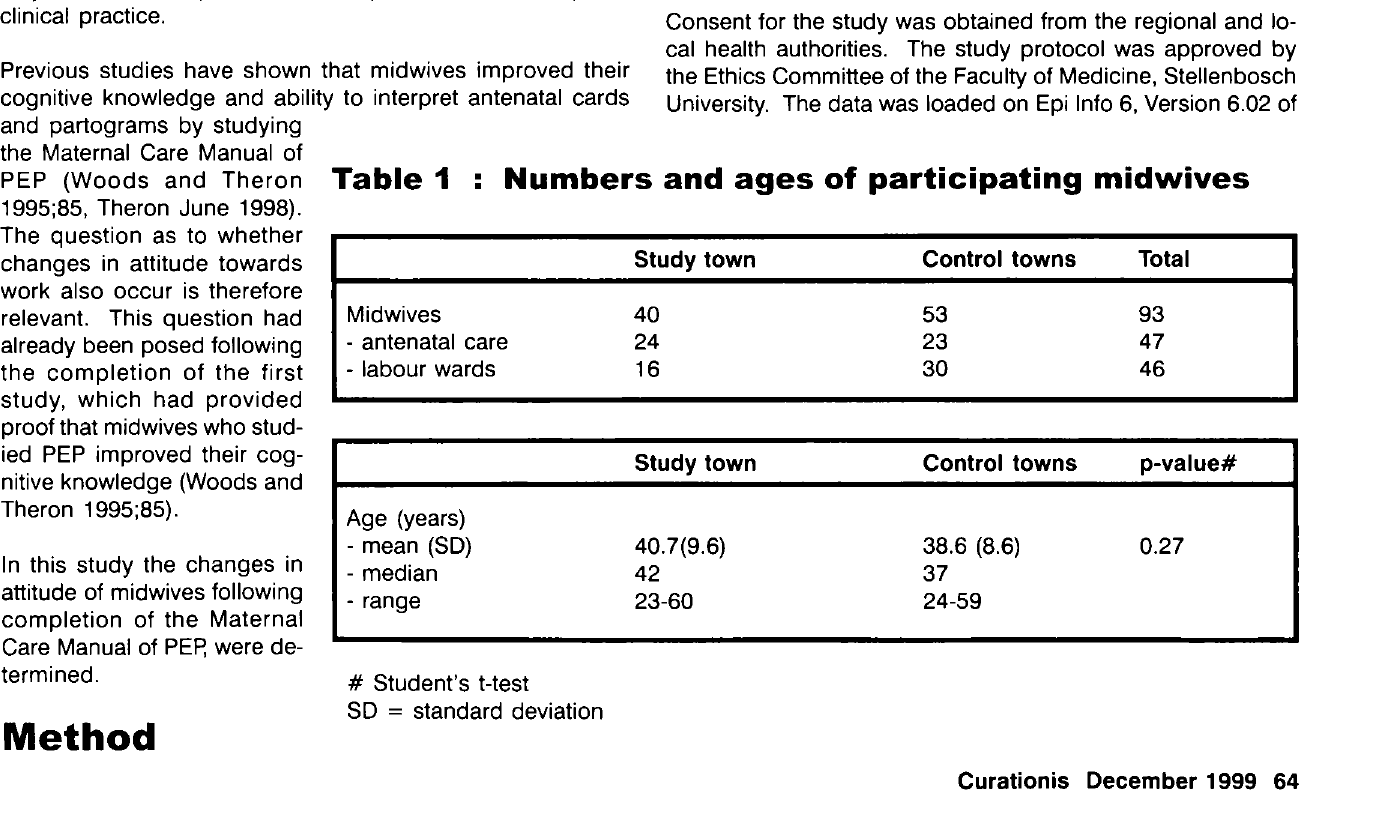
Table 1 : Numbers and ages of participating